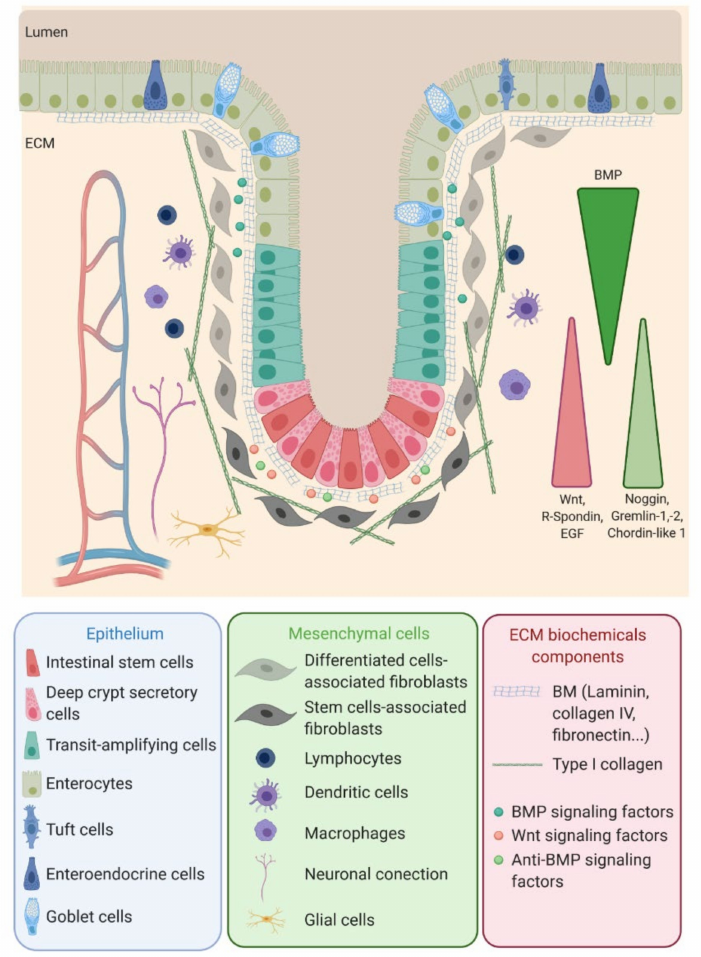
Figure 1. Intestinal stem cells (ISC), located at the bottom of the crypt, give rise to transit-amplifying (TA) cells that migrate along the crypt during their di ff erentiation while reaching the surface. ISC regulation, as well as the proliferation and di ff erentiation processes, are mediated by signals emanating from the surrounding mesenchymal cells, close-by epithelial cells and the interaction of the epithelial cells with the basal membrane. EGF: Epidermal Growth Factor, ECM: extracellular matrix, BMP: bone marrow protein and BM: basement